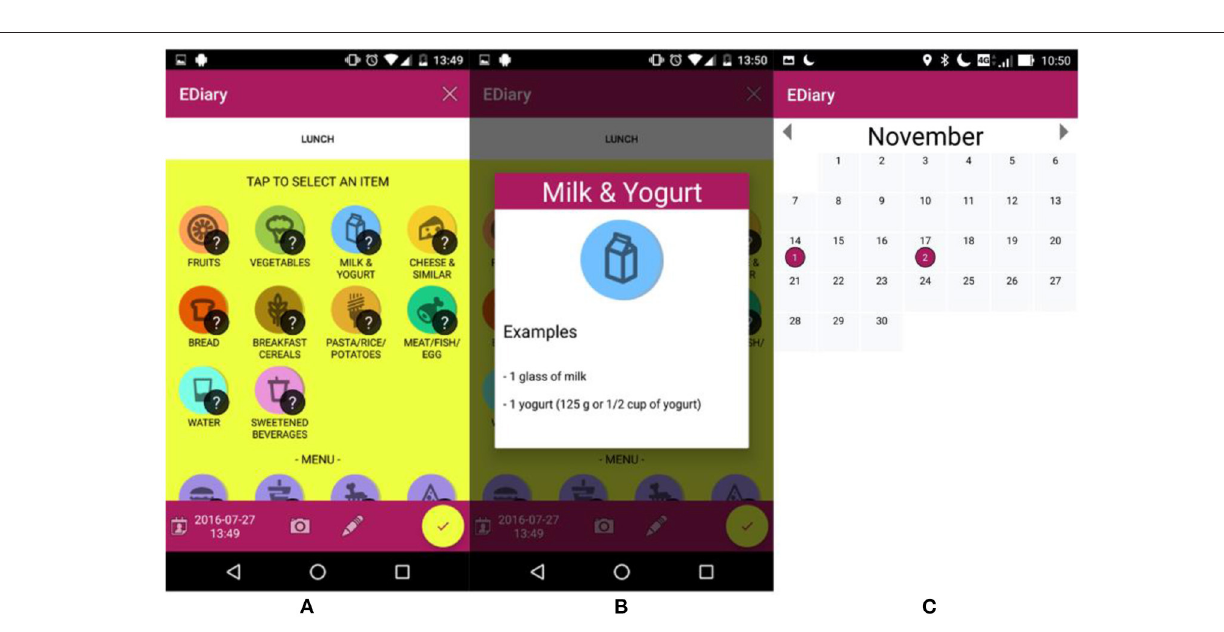
Frontiers in Nutrition |